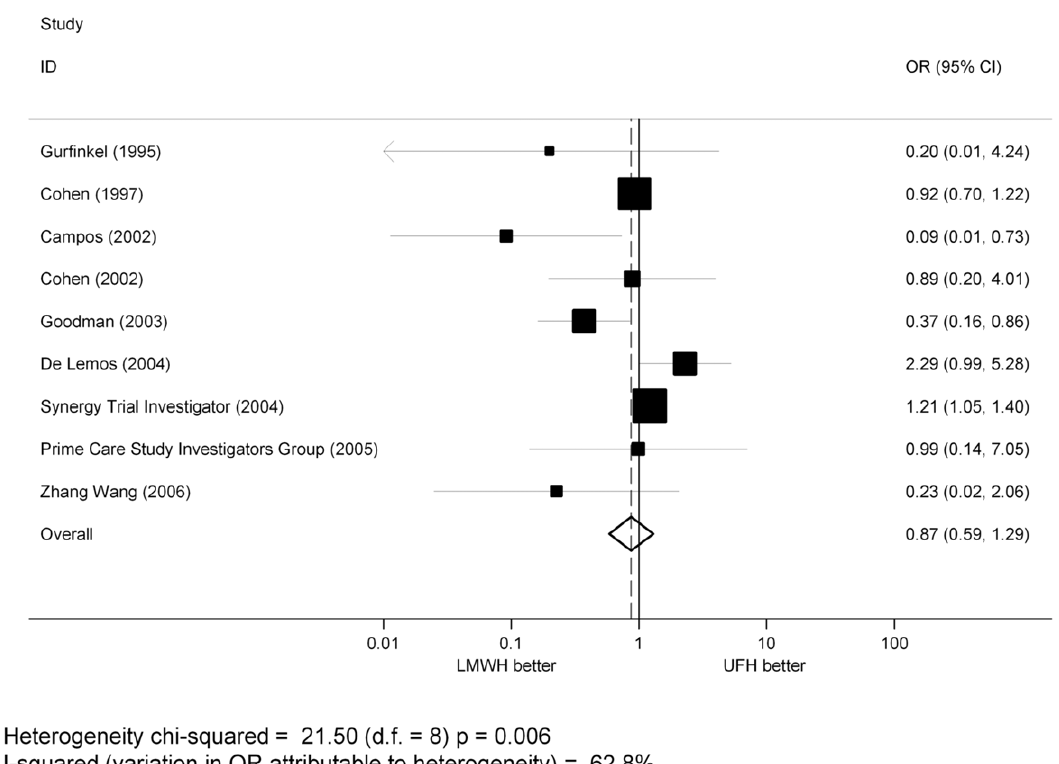
Figure 4. Pooled estimates of OR for major bleedings of LMWH versus UFH in ACS patients.